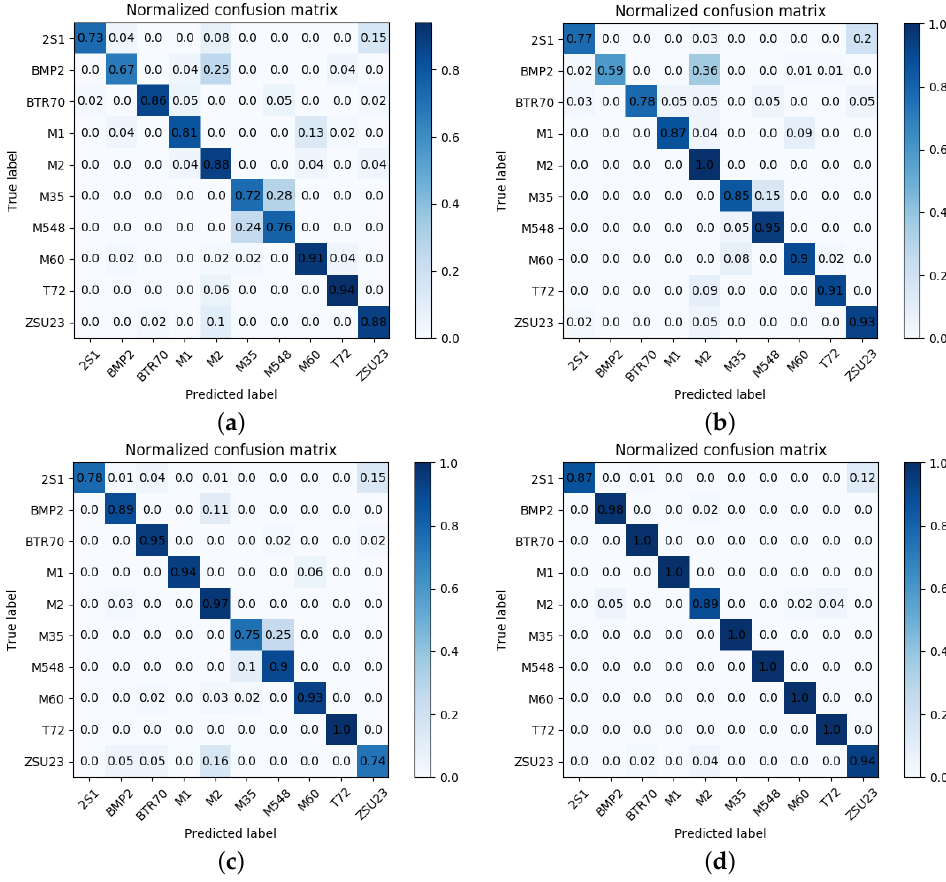
Figure 12. Confusion matrices of test data under Training Scenario II. ( a ) Without data augmentation. ( b ) With speckle noise augmentation. ( c ) With speckle noise augmentation and feature alignment. ( d ) With speckle noise augmentation, feature alignment, self-training, and pseudo-label denoising (SSIM